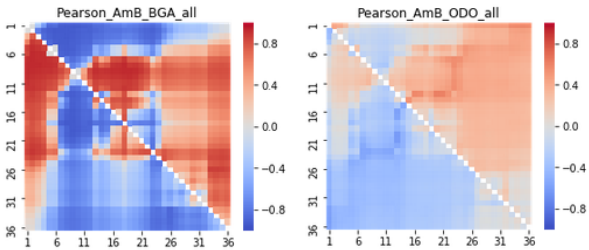
these indices with BGA: usually lower mutual correlation of the indices means more disparity in the corresponding scatter plots.